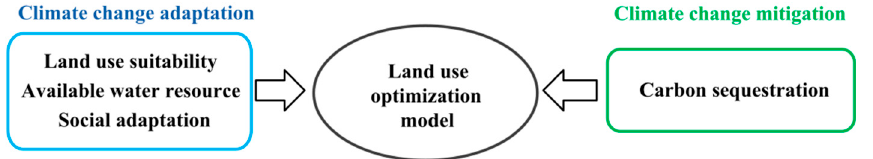
Figure 1. Land use optimization modelling framework for integrated climate change adaptation and mitigation.